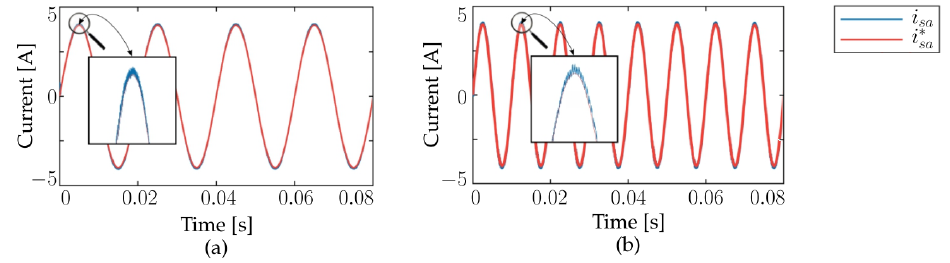
Figure 8. Current tracking results at different frequency values of the reference current. i ∗ sa = 4 A. ( a ) f = 50 Hz. ( b ) f = 100 Hz.